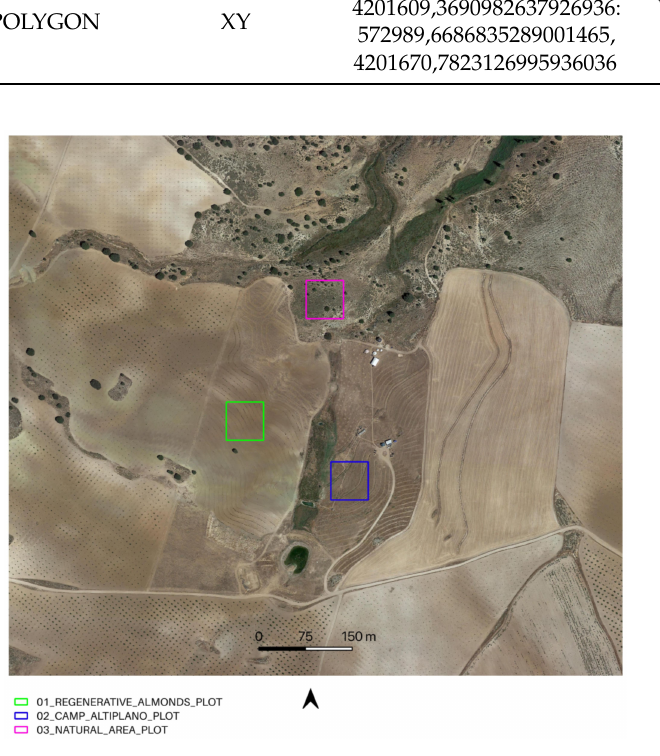
Figure 6. 01_REGENERATIVE_ALMONDS_PLOT.shp samples an exemplificative portion of the regenerative agriculture almonds planted with the keyline approach; 02_CAMP_ALTIPLANO_PLOT.shp samples an exemplificative portion of the landscape restoration actions, in the specificity of the forest garden extent, encompassing a portion of the riparian vegetation; 03_NATURAL_AREA_PLOT.shp samples a portion in the upper AOI, reforested with landscape restoration techniques and left to natural management, without human